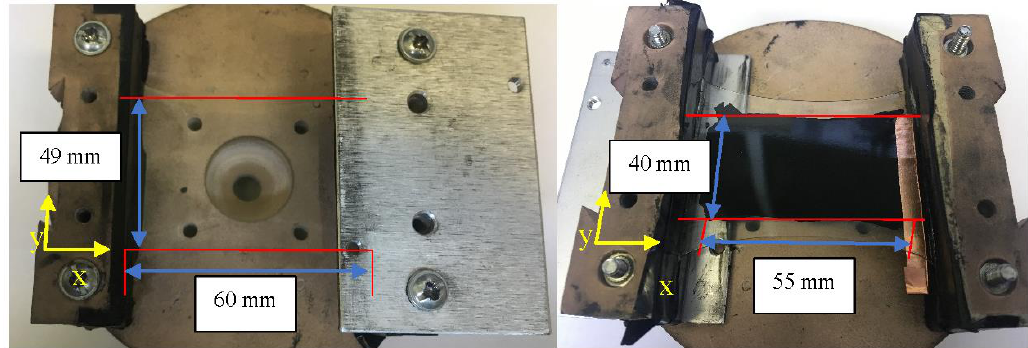
Figure 2. Stretched elastomer on the left and active surface of the DEA on the right.